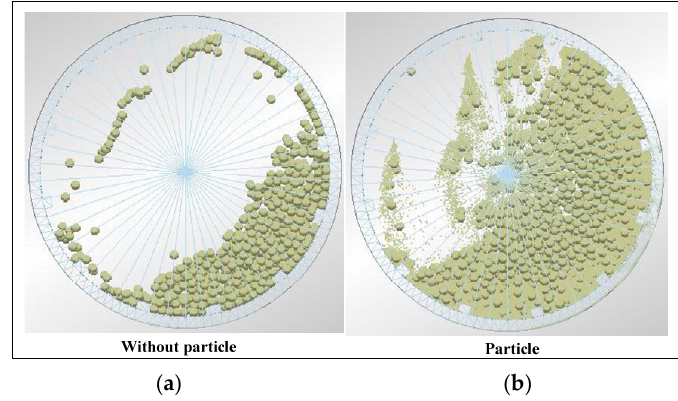
Figure 14. Photograph of the impact load behavior: ( a ) without particle and ( b ) with particle.